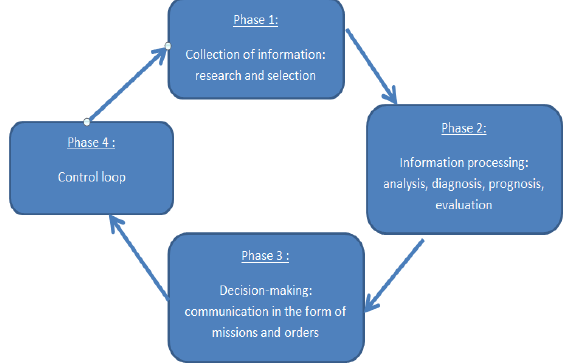
Figure 3. Figure Steps in the decision-making process of the